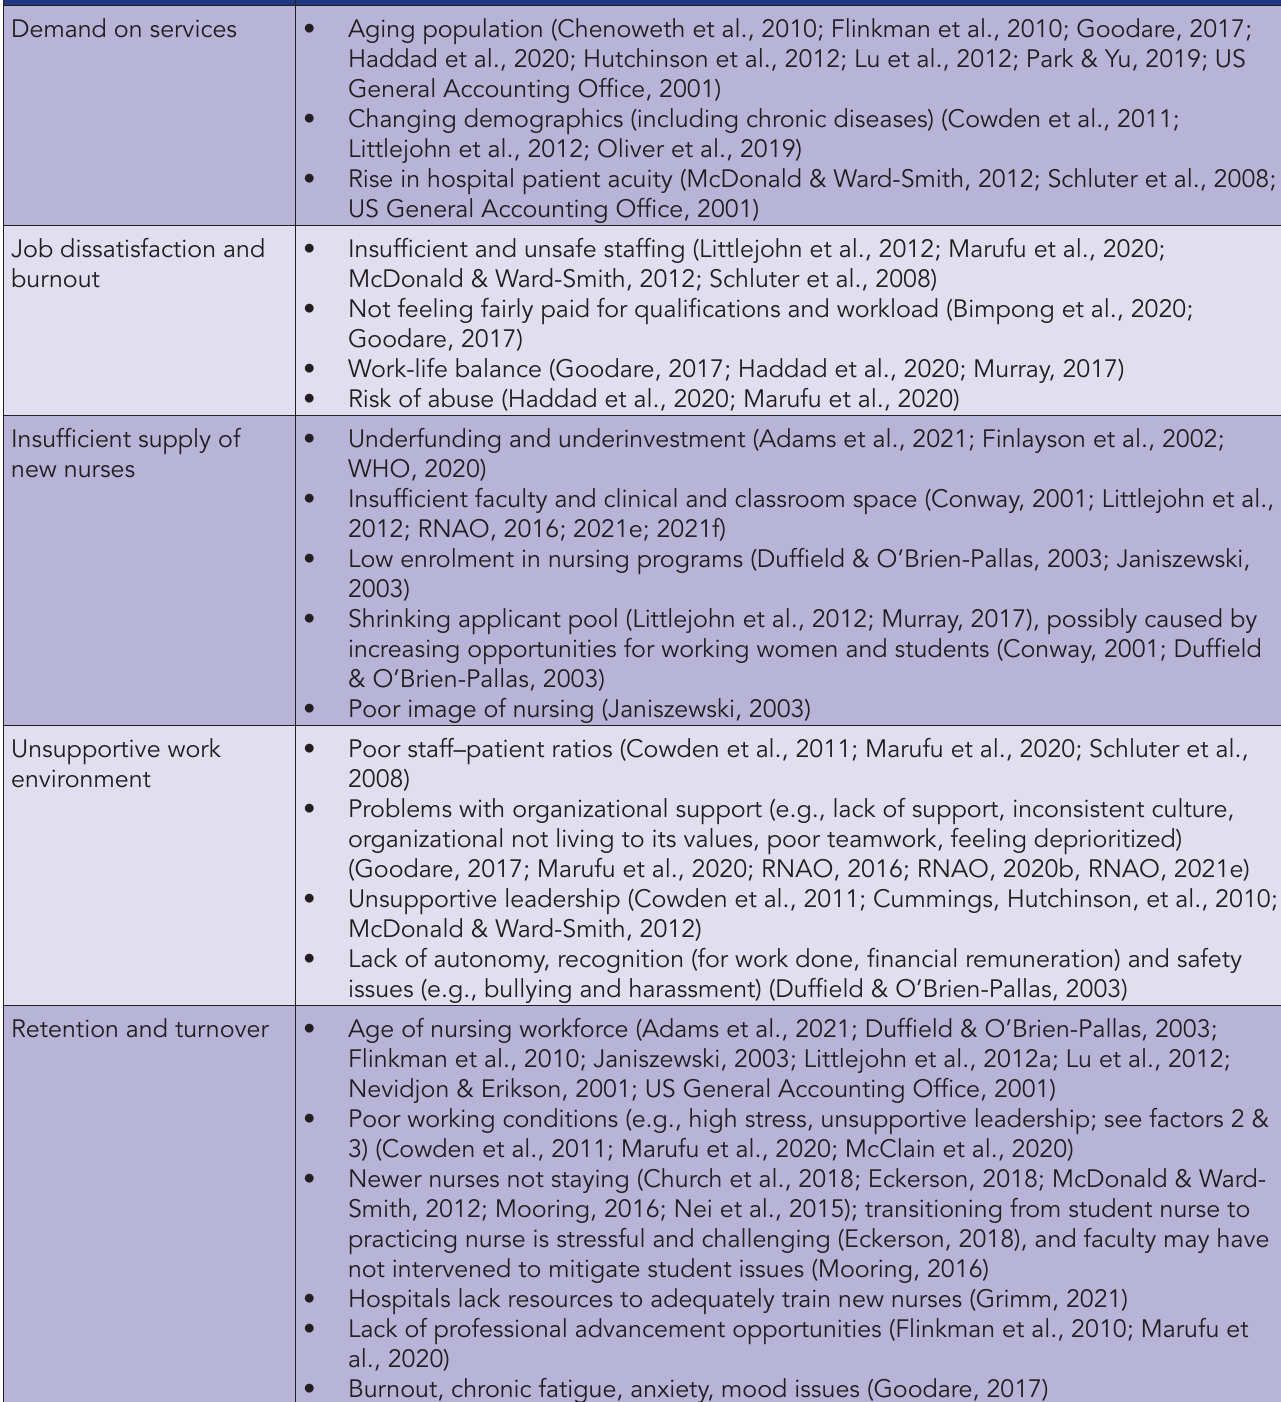
Table 10. Factors affecting nursing shortages – summary categories from literature Factors Causes Demand on